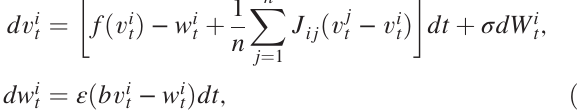
ξ a;i ξ I;i a þ σ and heterogeneous inputs I i ¼ I þ σ , t t i ¼ a I 0 . 5 and σ 1 . a ¼ I ¼